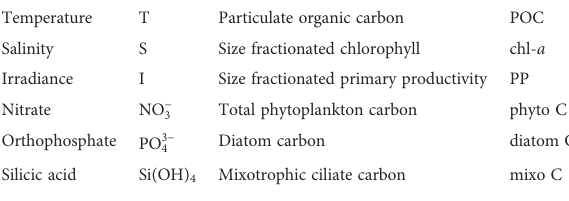
TABLE 1B Summary of measurements taken in vertical pro fi les at OSP in June 1998. Temperature T Particulate organic carbon